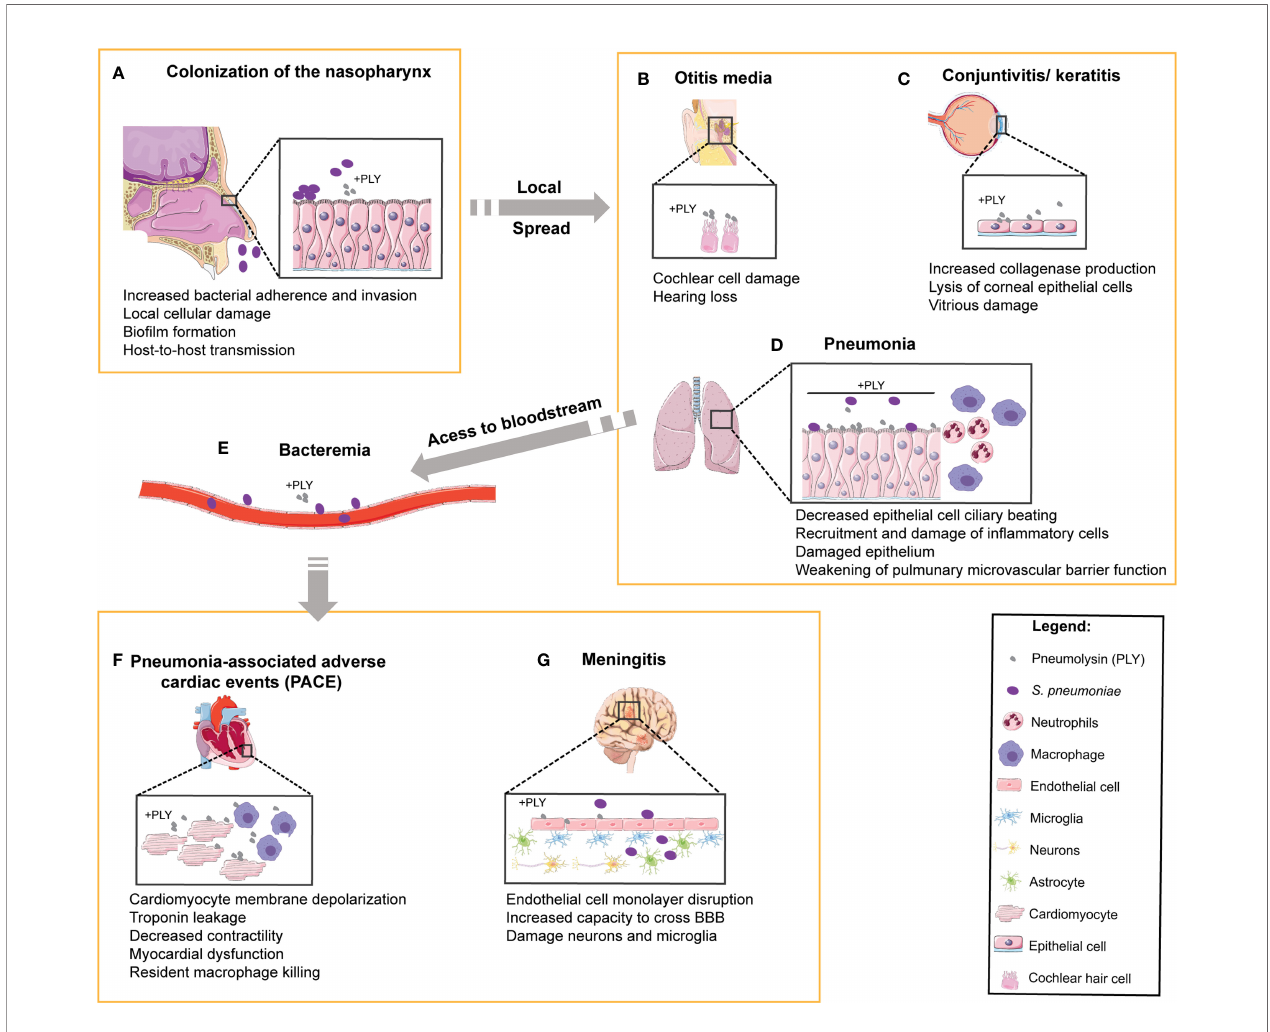
FIGURE 1 | Role of PLY in human pneumococcal pathogenesis and in the targeting of multiple organs. In the multiple steps of pathogenesis during human infection by S. pneumoniae , the target organs and the cell types involved are indicated and the reported functions of PLY are listed below each step. (A) S. pneumoniae colonizes the human upper respiratory tract. Prolonged colonization of the nasopharynx may favor bacterial spread to neighboring tissues such as (B) the middle ear, causing otitis media and massive damage of cochlear hair cells, and (C) the eyes, leading to the development of keratitis and endophthalmitis. Upon aspiration, S. pneumoniae can reach (D) the lower respiratory tract and cause pneumonia. In the lungs, PLY causes the dysfunction of epithelial barrier, facilitating bacterial access to (E) the bloodstream, where PLY diminishes phagocytosis and disrupts endothelial/epithelial cells to promote tissue invasion. The bacteria are then able to infect (F) the heart, causing pneumonia-associated adverse cardiac events (PACE) by targeting the cardiomyocytes and resident macrophages, and (G) the brain, causing damage of both neurons and